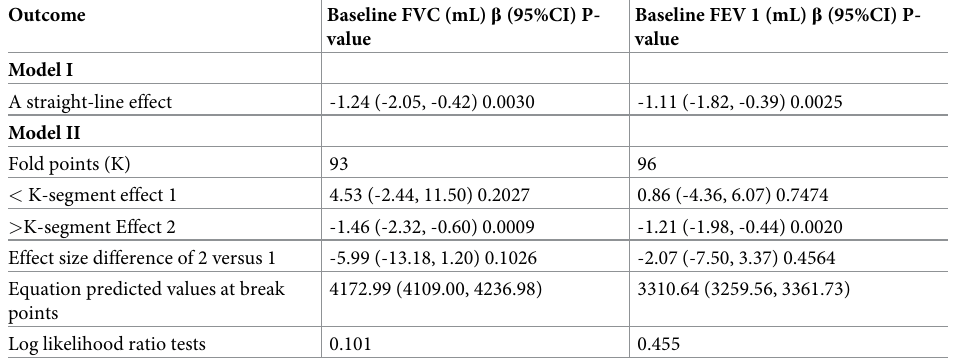
Table 4. Analysis of threshold effect and saturation